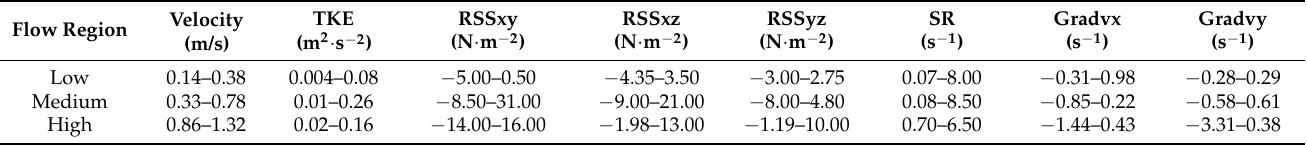
Table 1. The ranges of hydrodynamic parameters (flow velocity (V, m/s), turbulent kinetic energy (TKE, m 2 · s − 2 ), Reynolds shear stress in three planes (RSS xy , RSS xz , and RSS yz , N . m − 2 ), strain rate (SR, s − 1 ), and velocity gradients along (Grad vx , s − 1 ) and perpendicular to the direction of water flow (Grad vy , s − 1 ) corresponding to different flow velocity